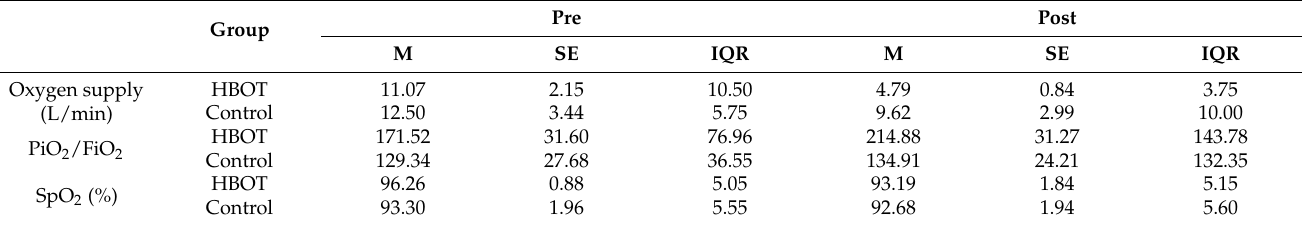
Table 1. Statistics for blood gas results at baseline and day